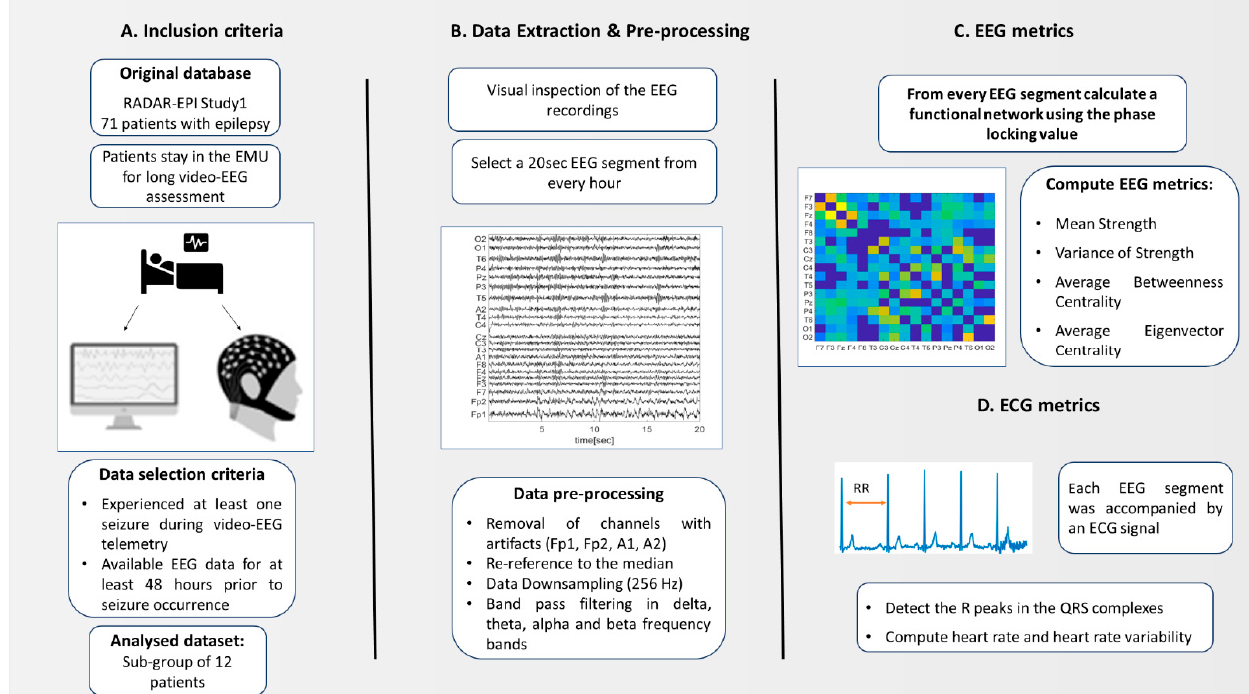
Figure 1. Summary of the data preprocessing and analysis pipeline.